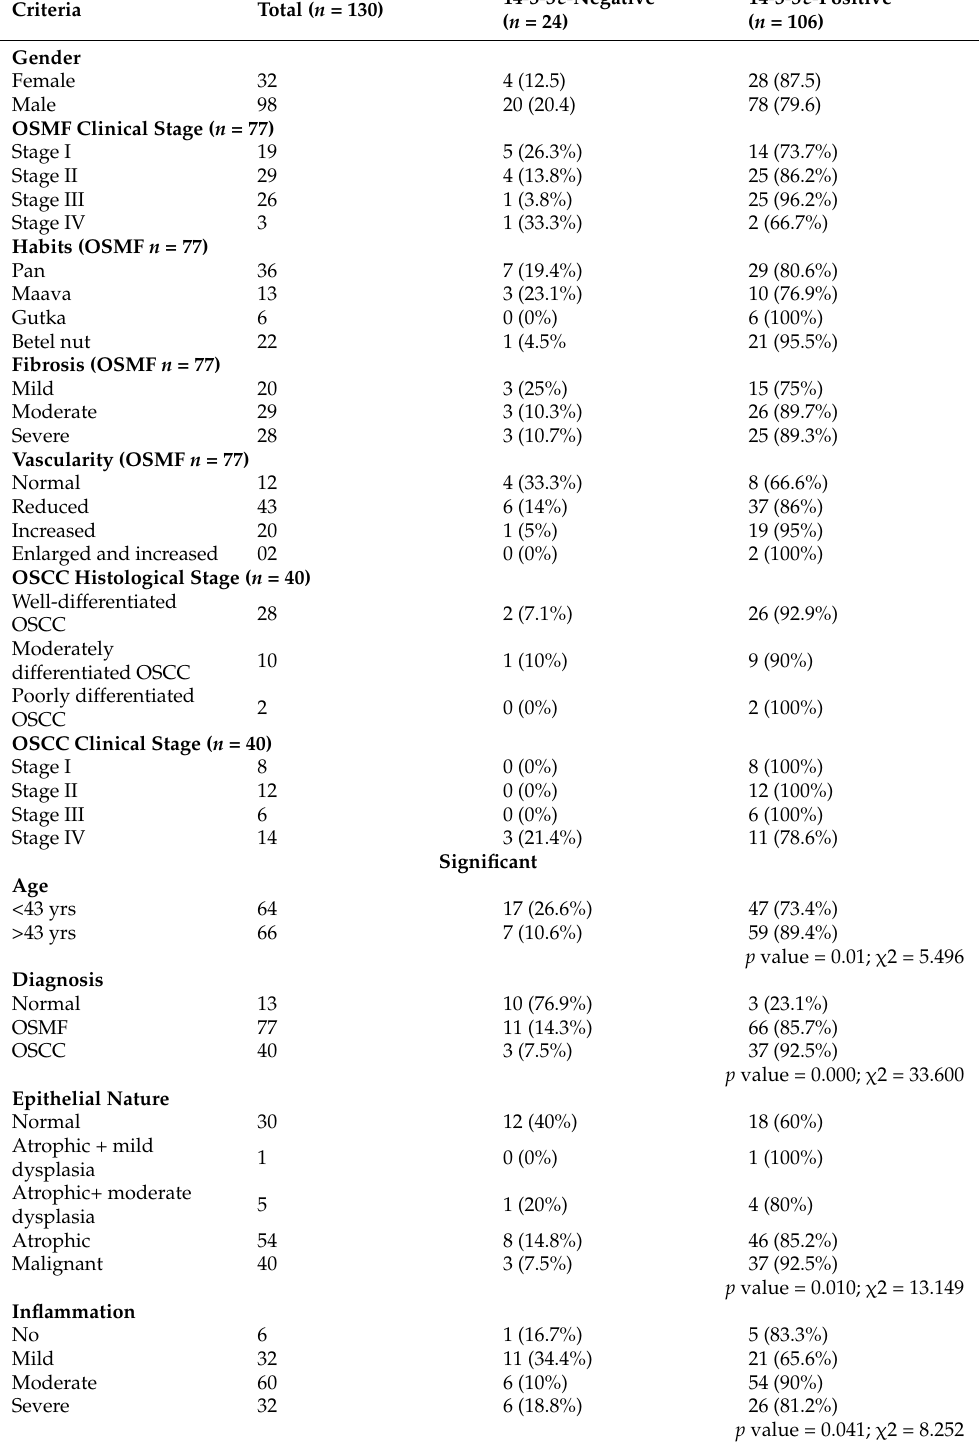
Table 4. Clinical histopathological features in 14-3-3 ε -positive and -negative groups of OSMF, OSCC and normal